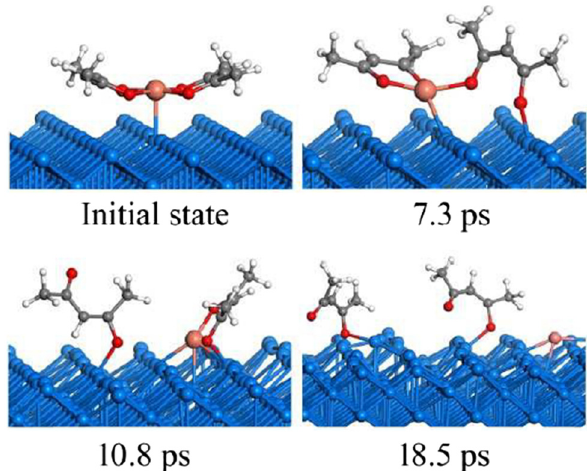
Figure 16: Reactive MD dissociation of copper ( II ) acetylacetonate on the Cu ( 110 ) surface [ 154 ] . Initially, the Cu – O bond broke and the acac - ligand tilted ( 7.3 ps ) . The acac - ligand then totally dissociated from the Cu ( acac ) 2 molecule, thereby creating acac and Cu ( acac ) species on the surface ( 10.8 ps ) . Finally, Cu ( acac ) dissociated into copper and acac species on the surface after 18.5 ps [ 154 ] .